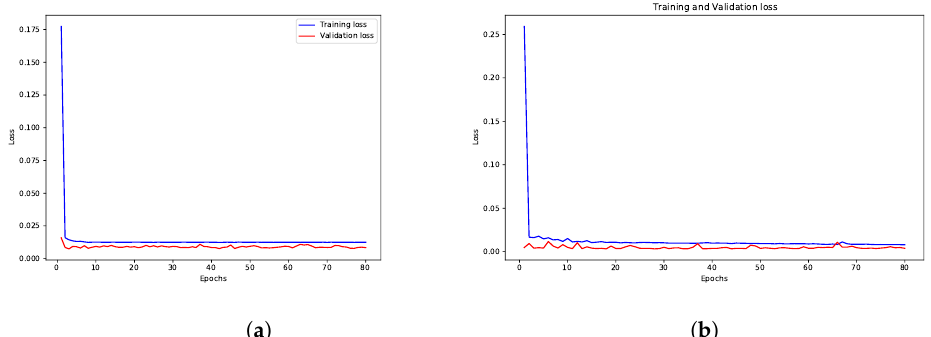
Figure 8. Training vs. validation loss based on BO-LSTM. ( a ) Training vs. validation loss for Site I. ( b ) Training vs. validation loss for Site II.